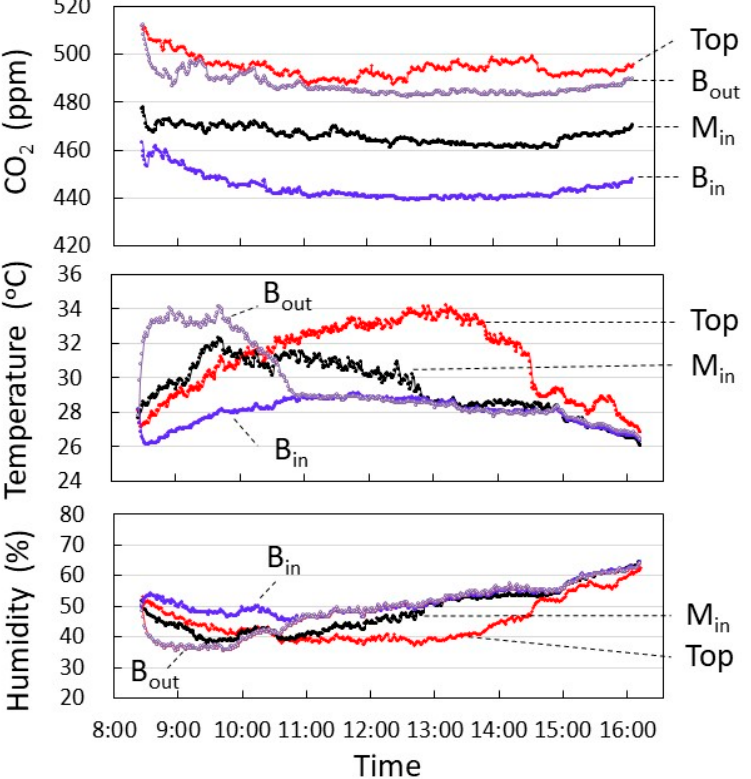
Figure 6. CO 2 concentration, temperature, and humidity of each layer measured in September. Data on clear days from 24–29 September were averaged to show time changes. It also showed lower temperatures than Top after 10:30 a.m. in M in and B in . The relationship between the chlorophyll content (SPAD) of each layer and the leaf lightness (L*) is shown in Figure 7. In both cultivars, leaves with lower L* tended to have higher SPAD. This indicates that leaves with higher SPADs have more chlorophyll, which absorbs light, and lower brightness due to less reflected light.